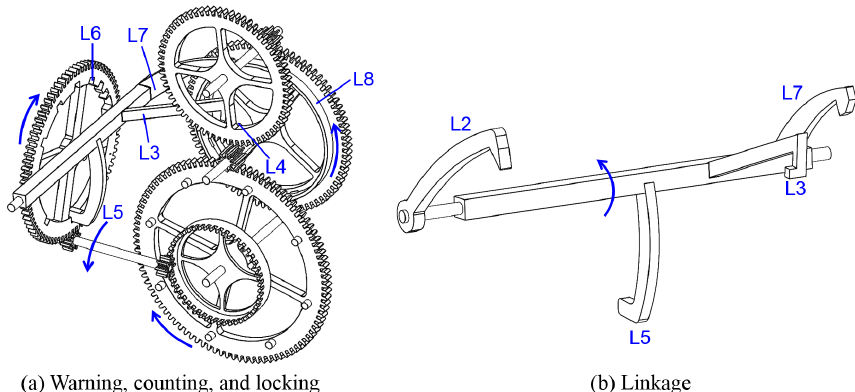
Figure 35. Structure and operation of the N14 trigger mechanism. (The trigger is similar to that of